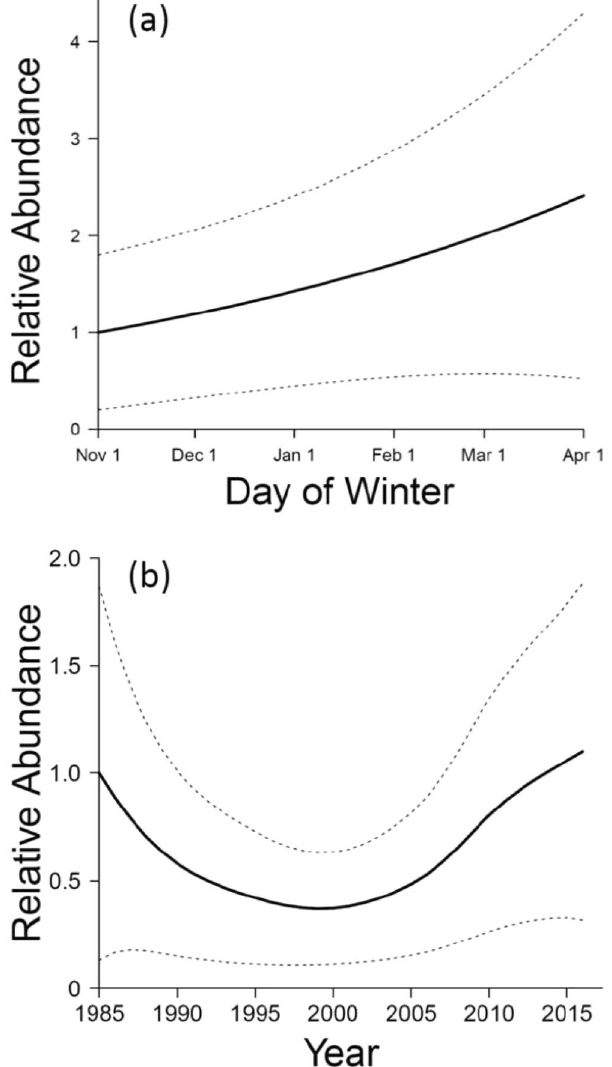
Figure 2. Relative abundances (solid lines) ± 95% CI s (dotted lines) of hibernating western small-footed myotis by ( a ) day of winter and ( b ) year. Trajectories are from the best model, based on 173 surveys in 23 caves in southern Idaho, USA, from winter 1984–1985 (labeled as 1985 in panel b) to winter 2015–2016.